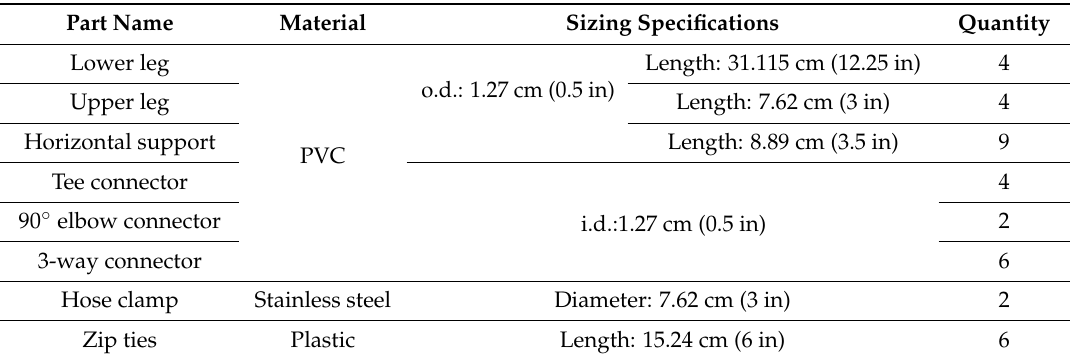
Table 2. The following is a complete parts list for the soil column stand portion of the complete soil column system, as shown in Figure 1c.